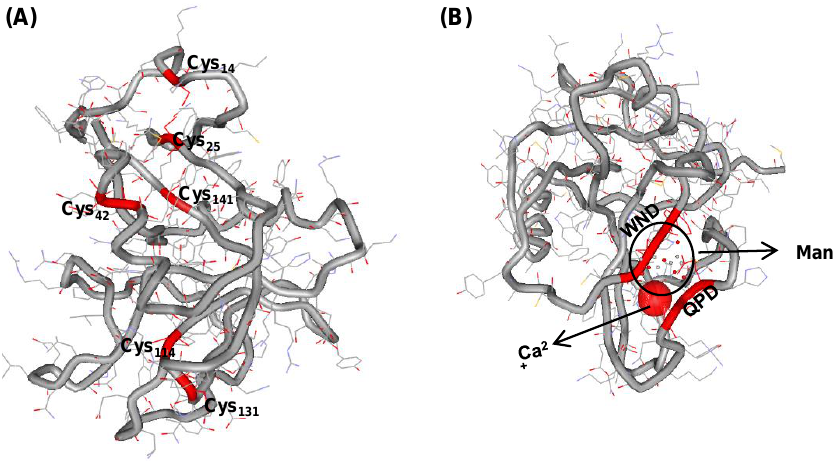
Figure 3. Three-dimensional structure of the AbCTLD protein. ( A ) Six conserved cysteine residues are shown in the three-dimensional structure of AbCTLD. ( B ) A ligand prediction algorithm was used to identify the binding sites of Ca 2+ ( C -score: 0.15) and Man (mannose, C-score: 0.44).